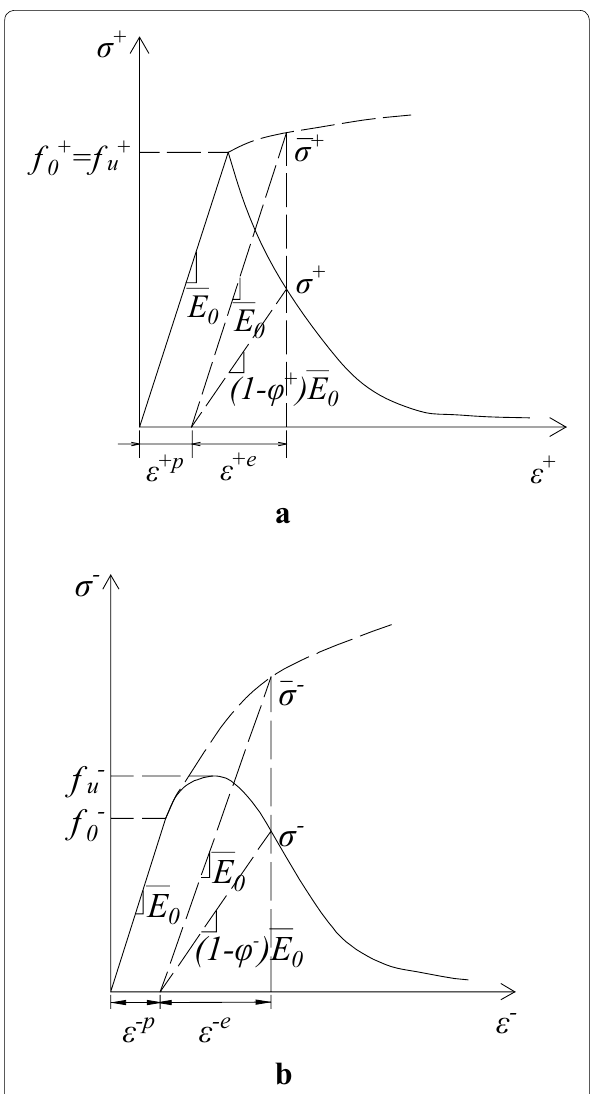
Fig. 1 Concrete behavior under uniaxial ( a ) tension and ( b )